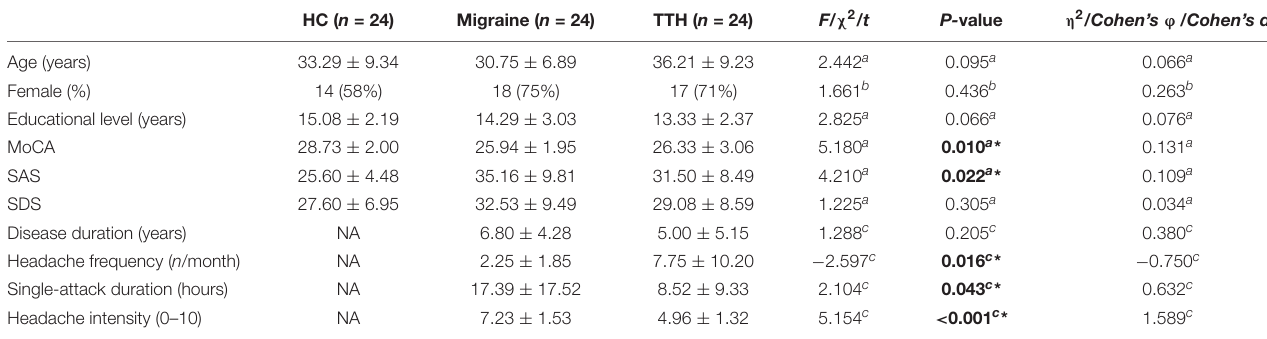
TABLE 1 | Demographic, psychometric, and headache characteristics of all